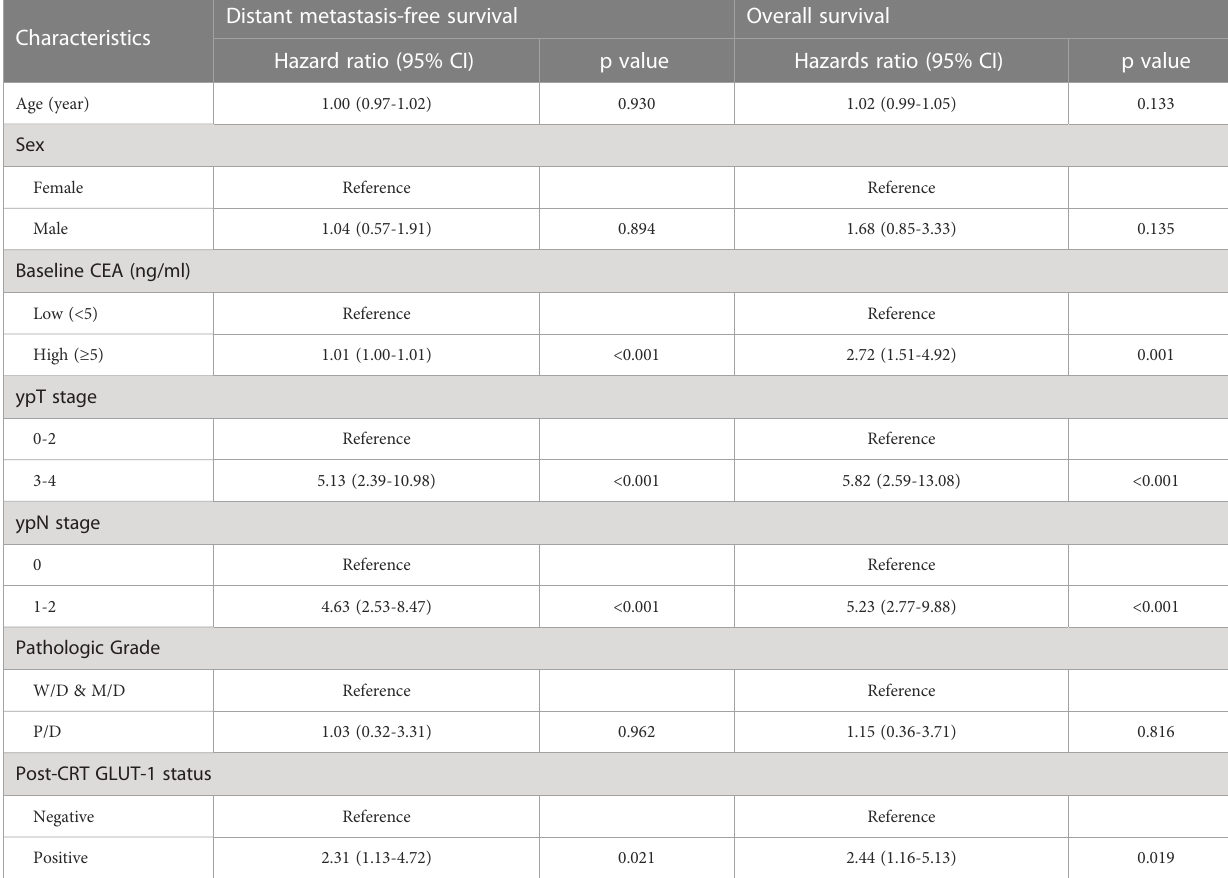
TABLE 2 Results of univariate Cox analysis for distant metastasis-free survival and overall survival.